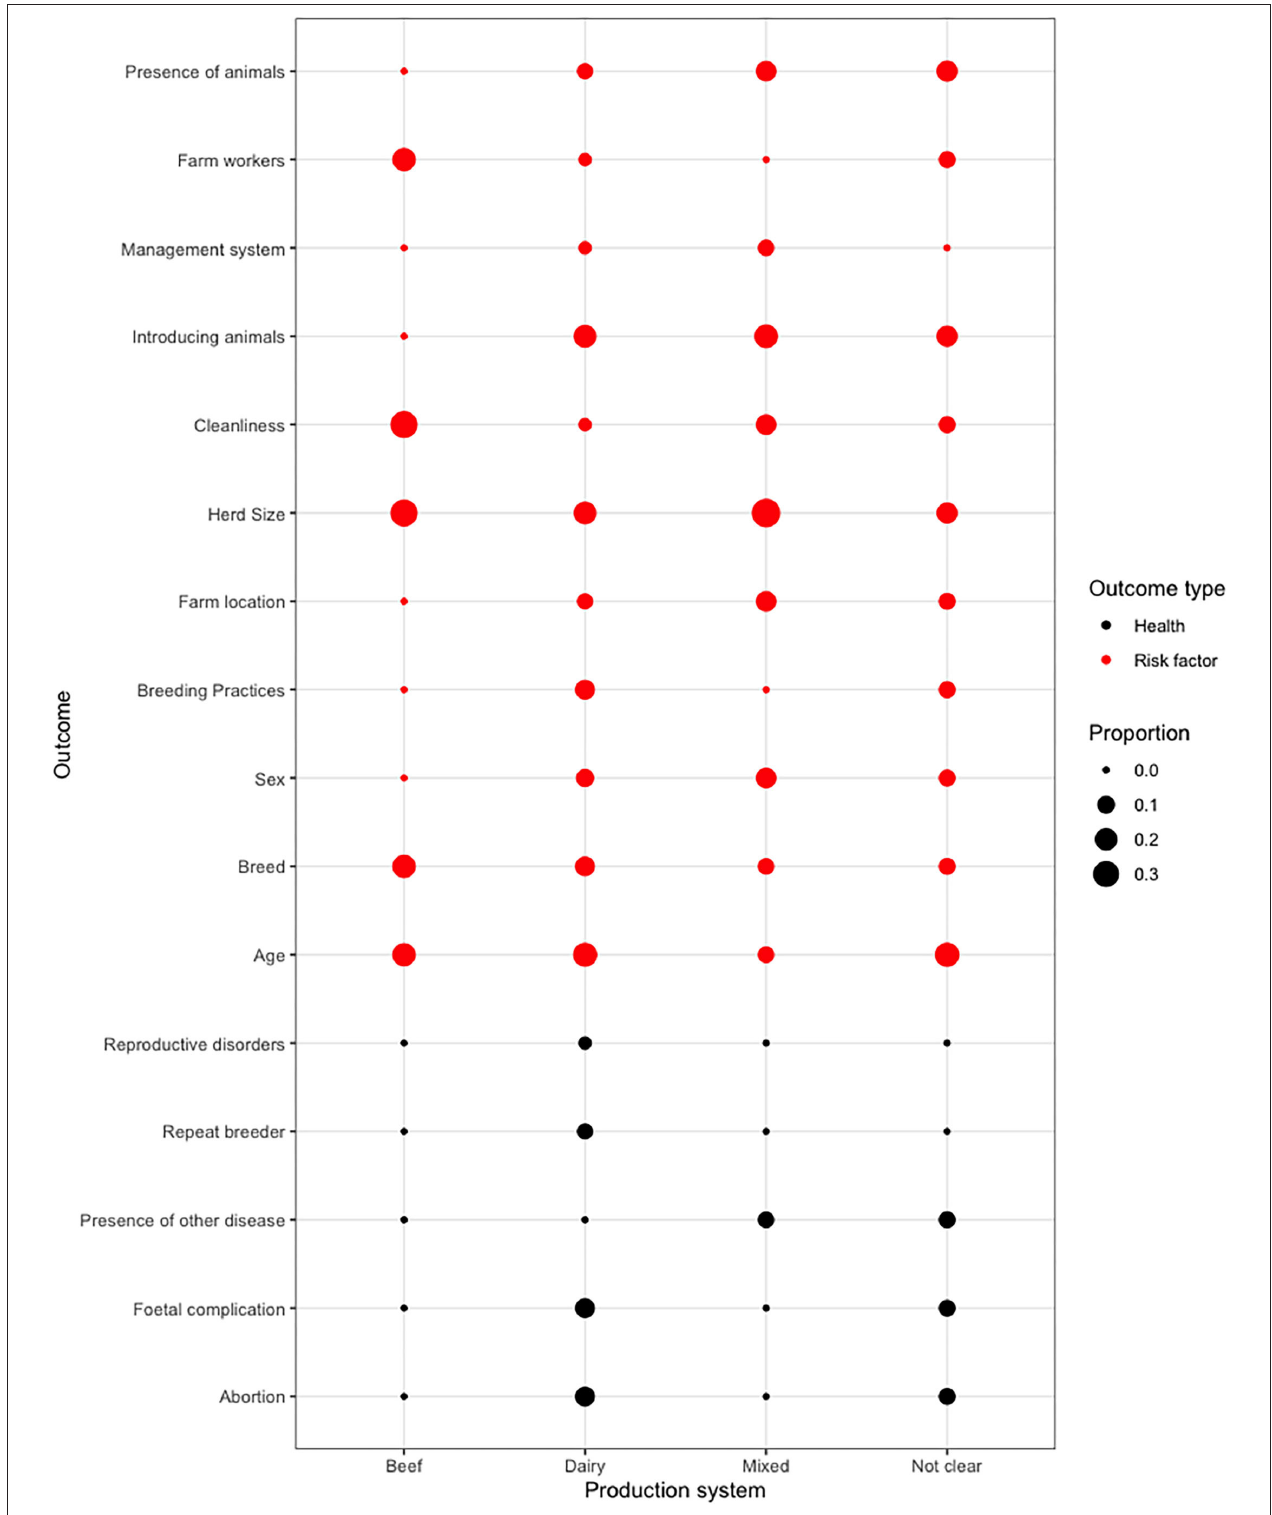
FIGURE 7 | A dot matrix plot showing risk factors and health impacts reported by production system. The plot shows a meta-analysis of the pooled studies. The size of the points represents proportion of studies that reported the risk factor or health impact of BVDV for a given production system. The proportions were calculated by the formula: number of confirmed risk factor papers/total number of papers in each production system. Detailed explanations of the risk factors and how they have been grouped can be found in Supplementary Table S3 .